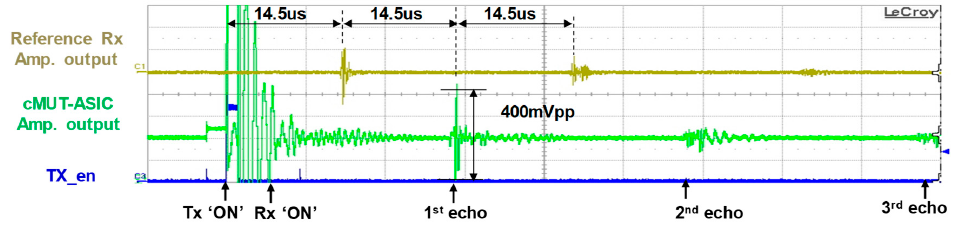
Figure 4. Measurement result for Tx and Rx pulse-echo test in CMUT array.